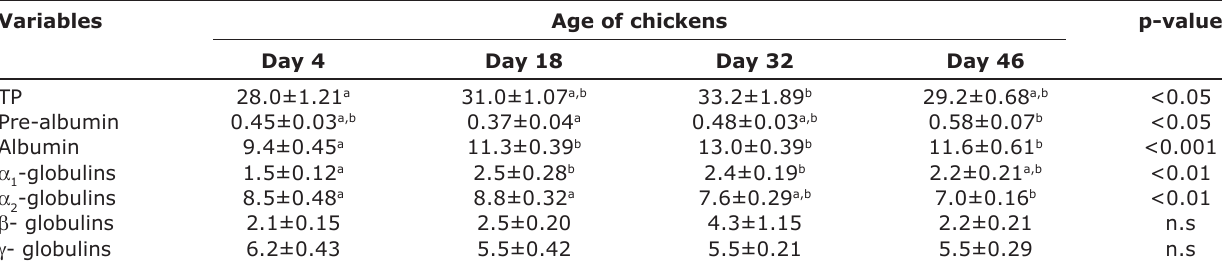
Table-3: Changes in the absolute concentrations of total serum protein and protein fractions (g/l) in broiler chickens during the fattening period (mean±SE).